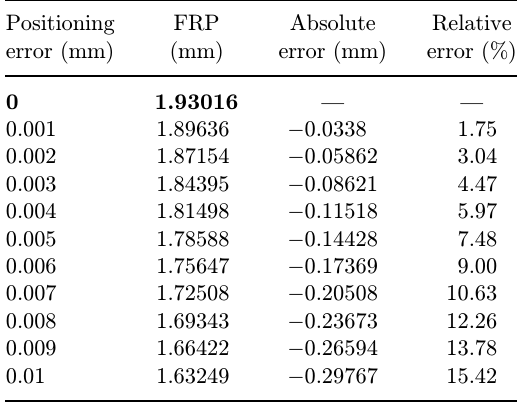
Table 5. The error caused by di®erent magnitude positioning inaccuracy.